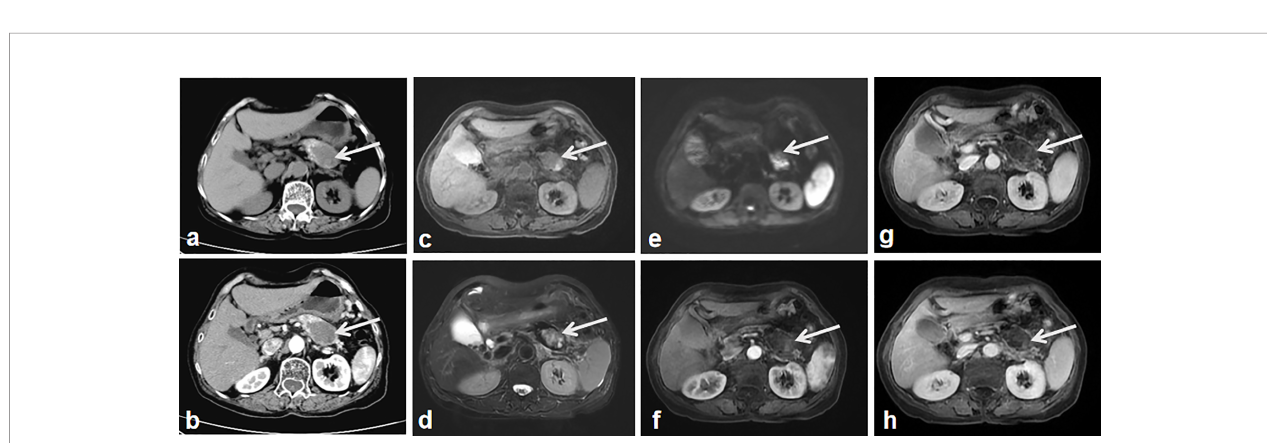
FIGURE 2 | The second imaging. CT without contrast administration show the signi fi cantly enlarged tumor mass with heterogeneous components of central cystic low attenuation, peripheral solid isointensity and small patchy calci fi cation ( A , arrow). Contrast-enhanced CT shows the tumor mass with intermediate enhancement of the peripheral component and the non-enhanced cyst-like central area ( B , arrow). MR T2 (C) and T2 weighted images (D) show heterogeneous hyper-signal intensity and hypo-signal intensity in the central area of the tumor (arrow). DWI shows the apparent diffusion restriction-induced heterogeneous hypersignal intensity ( E , arrow). Contrast-enhanced MR weighted images of arterial (F) , portal (G) and equilibrium phase (H) show the tumor mass with intermediate enhancement of the peripheral component, the non-enhanced cyst-like central area